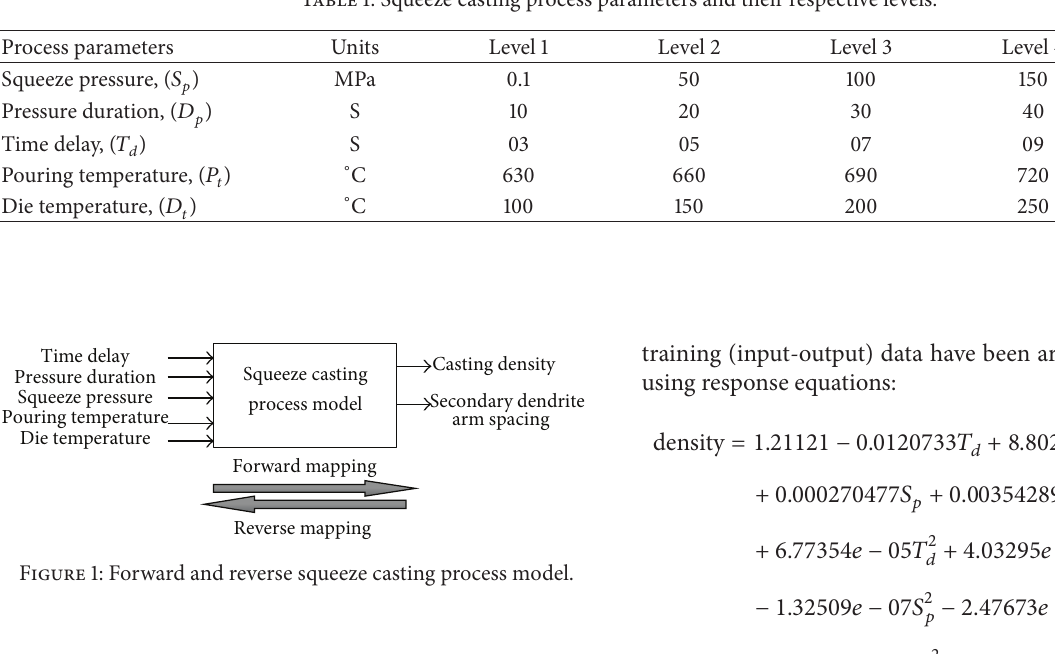
Table 1: Squeeze casting process parameters and their respective levels.